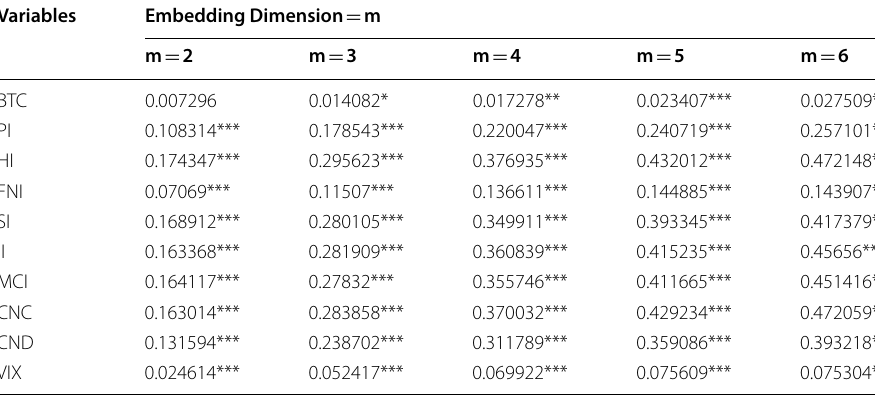
Table 6 Nonlinearity Brock-Dechert-Scheinkman (BDS) test